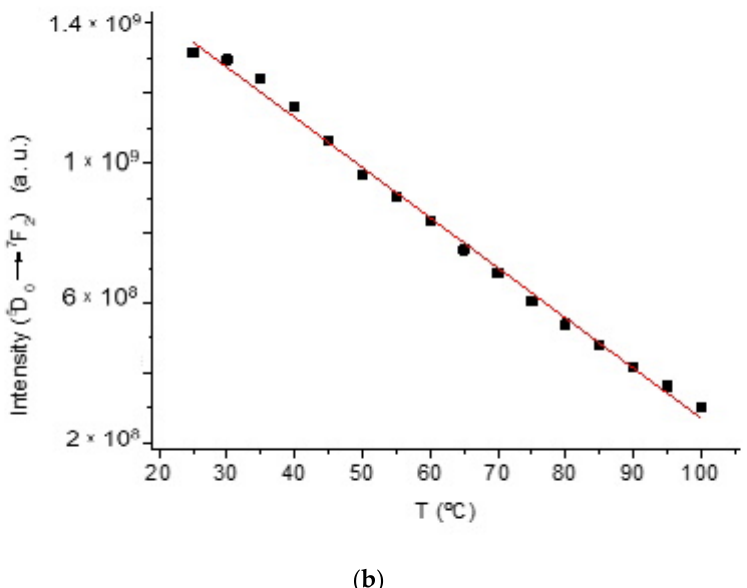
Figure 6. ( a ) emission spectra of 1/PSU at different temperatures upon excitation at 320 nm. Most intense blue line at room temperature, less intense red line acquisition ate 135 °C; ( b ) total intensity of 5 D 0 → 7 F 2 transition band between 25 and 100 °C with 5 °C step, y = − 1.43x + 1.70 (r 2 = 0.99).